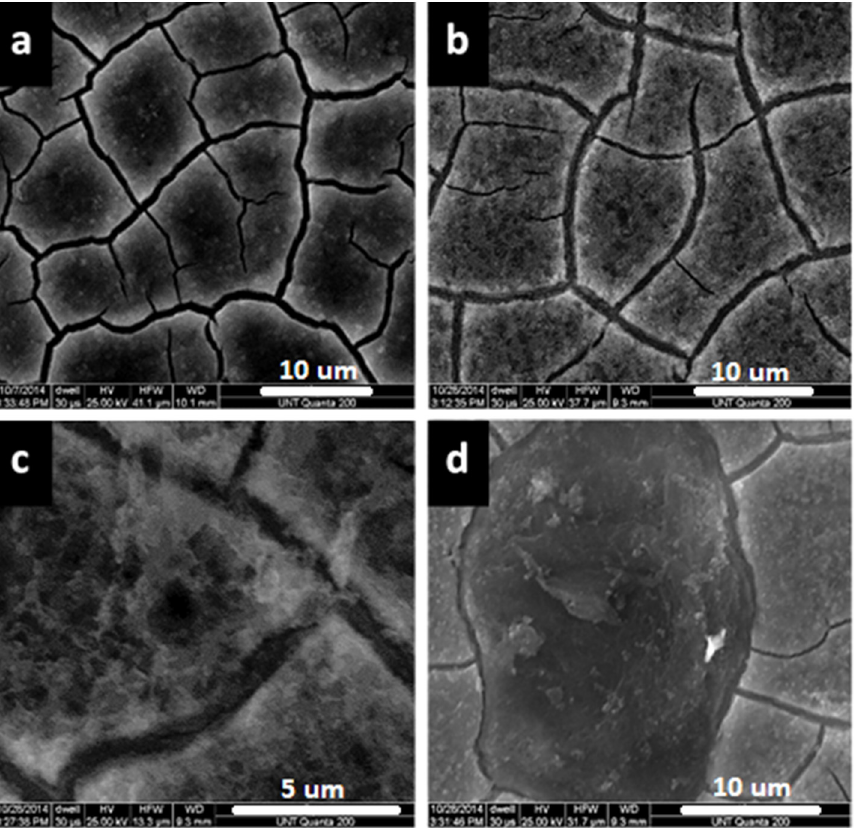
Figure 8. SEM images of 5L film ( a ) before and ( b ) after immersion in 3.5 wt.% NaCl solution for 168 h as well as ( c ) an enlarged image of a defect in the immersed film from ( b ), and ( d ) top section of 5L film removed after 168 h.